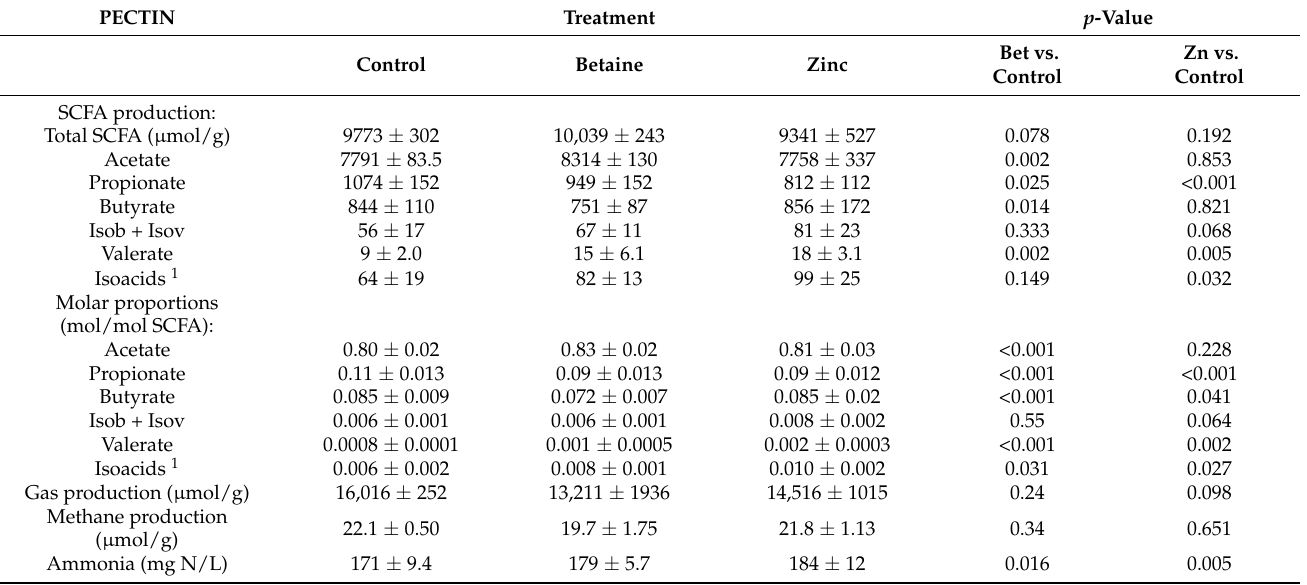
Table 2. Production of SCFA, molar proportions of SCFA, gas and methane production, and ammonia concentration after 24 h in vitro fermentation of pectin by fecal inocula obtained from pigs under heat stress conditions and fed diets supplemented or not with betaine (5 g/kg) or zinc (0.120 g/kg). Means ± standard deviations are